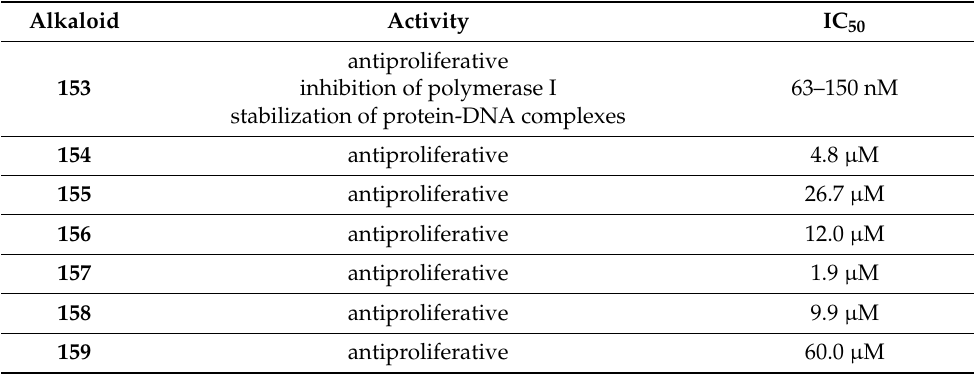
Figure 40. Dercitin analogs 153 – 159 . Table 3. Antiproliferative activity of dercitine analogs 153 – 159